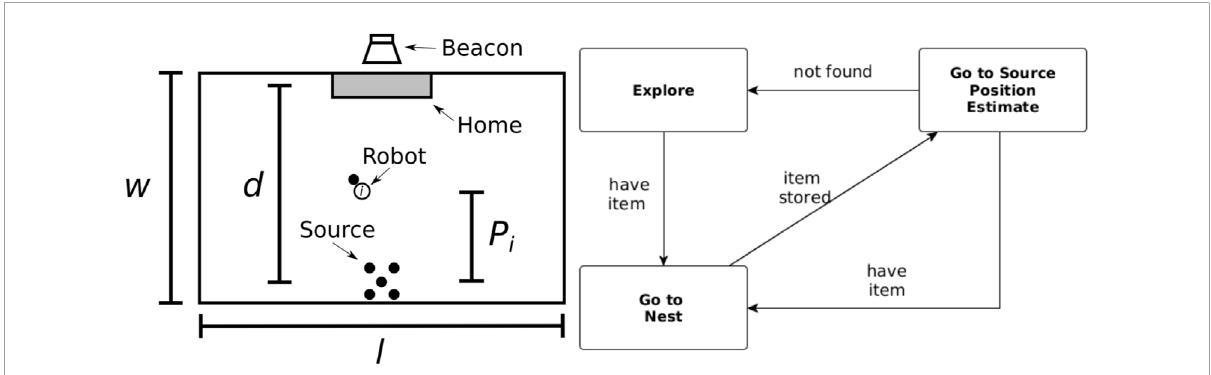
FIGURE 1 Foraging arena (left) and the finite state machine used by the robots (right). Left: the arena has a rectangular shape defined by its width (w) and length (L). The distance between the home area and the items’ source is represented by d . P i represents the individual partition length for robot i . Right: non-partitioning strategy finite state machine composed of three states: explore , go-to-nest , and go-to-source